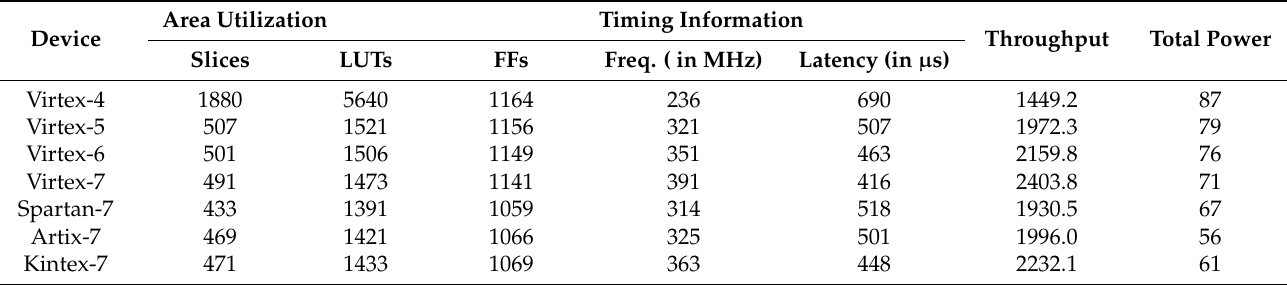
Table 1. Synthesis results over GF ( 2 163 ) on different FPGA